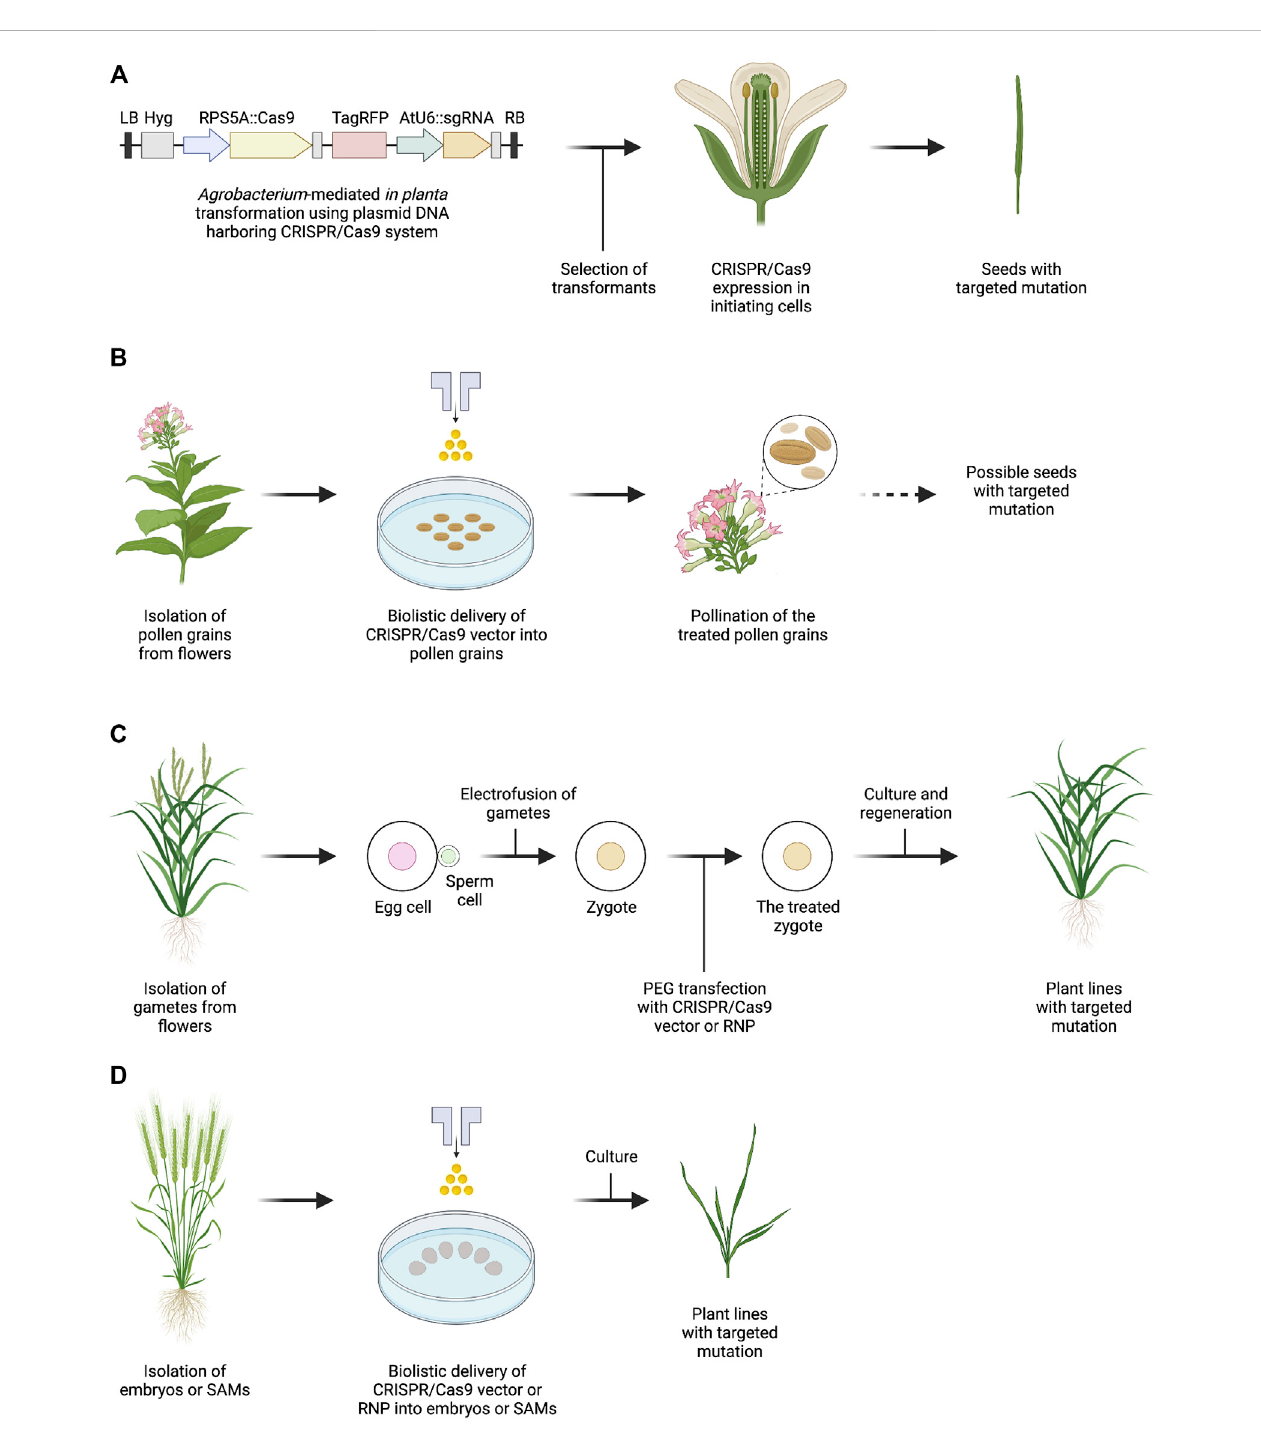
FIGURE 1 Outline of genome editing methods for plant reproductive cells or tissues. (A) Agrobacterium -mediated in planta transformation with CRISPR/ Cas9 vector in which promoters for Cas9 expression are speci fi cally expressed in Arabidopsis initiating cells. Vector information is taken with reference to Tsutsui and Higashiyama (2017). (B) Biolistic delivery of CRISPR/Cas9 vector into tobacco pollen grains. The dotted arrow indicates a procedure that has not been experimentally tested. (C) PEG-Ca 2+ -mediated transfection of rice zygotes with CRISPR/Cas9 vector or Cas9-gRNA RNP. (D) Biolistic delivery of CRISPR/Cas9 vector or Cas9-gRNA RNP into cells of wheat embryos and SAMs. The fi gure was created with BioRender.com.